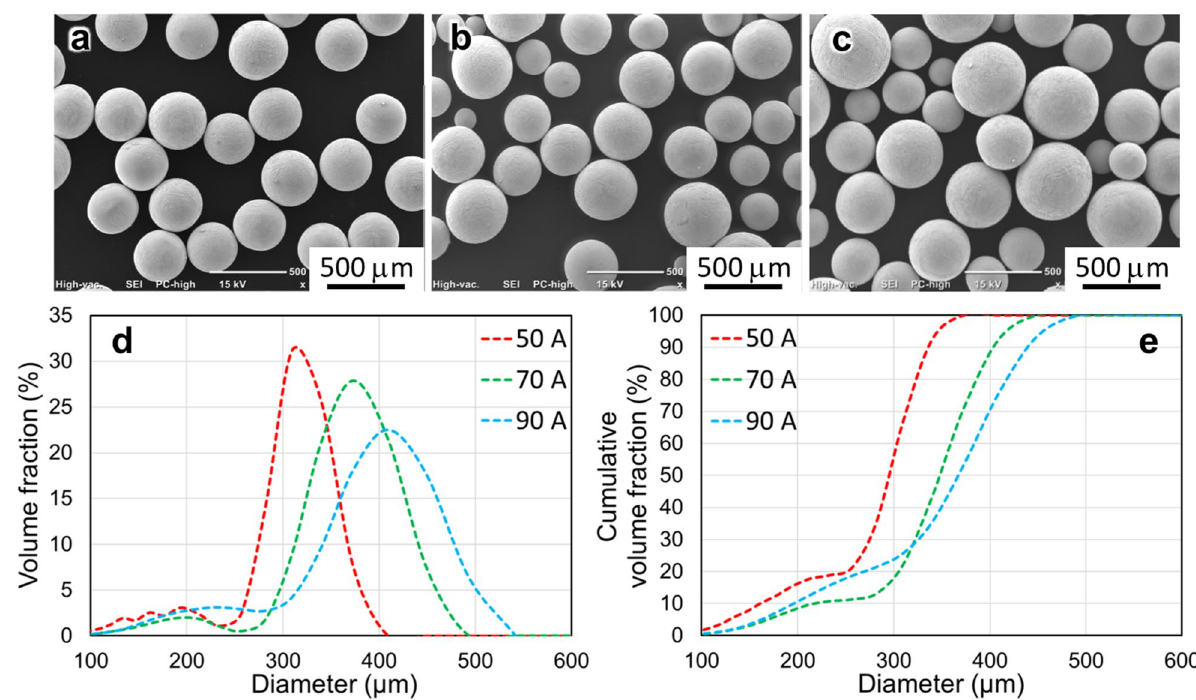
Figure 3. ( a – c ) SUS316 powders and ( d , e ) corresponding PSD fabricated using an electrode with a diameter of 20 mm, at 7000 rpm and currents of ( a ) 50, ( b ) 70, and ( c ) 90 A.